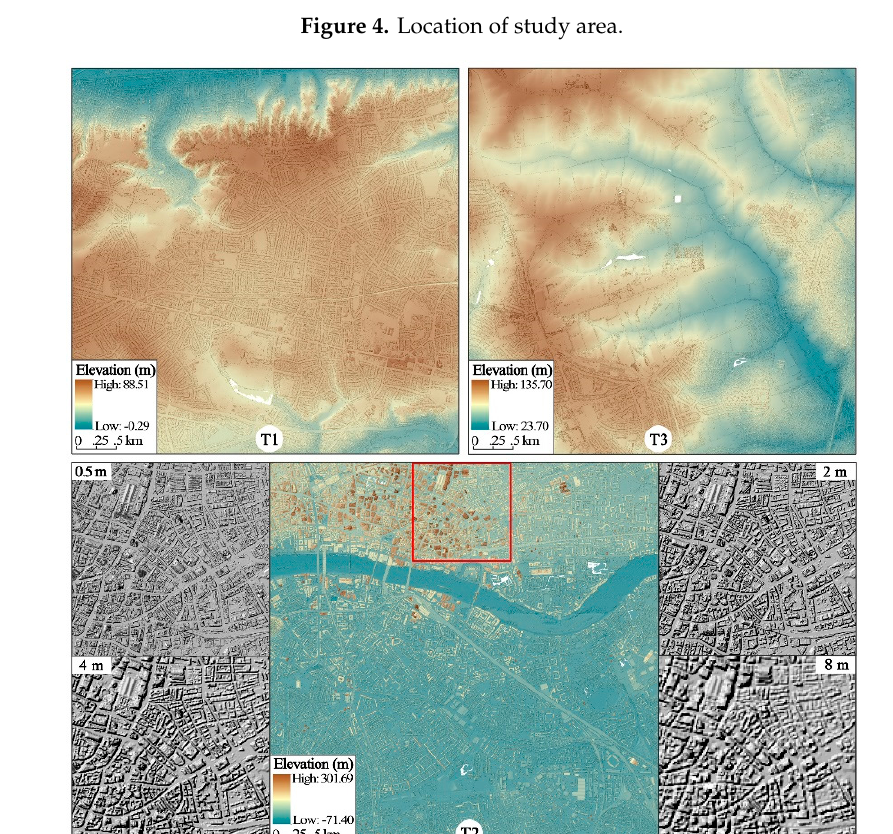
Figure 5. Urban digital elevation models (DEMs) of the training areas, where T1, T2, and T3 denote the training areas 1, 2, and 3, respectively.